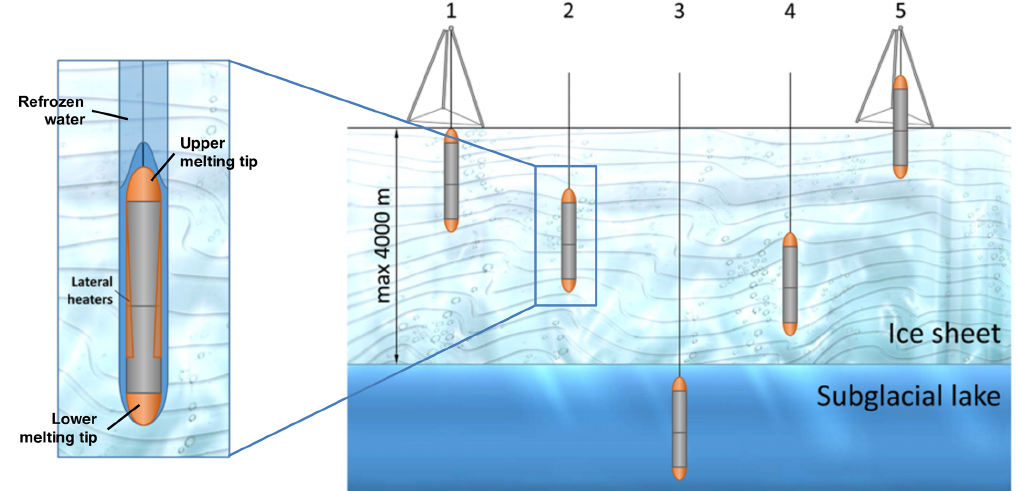
Figure 1. RECAS subglacial access and sampling operations: 1 – activation of the sonde; 2 – drilling downwards; 3 – lake sampling; 4 – drilling upwards; 5 – arrival to the surface (modified from Talalay et al., 2014).